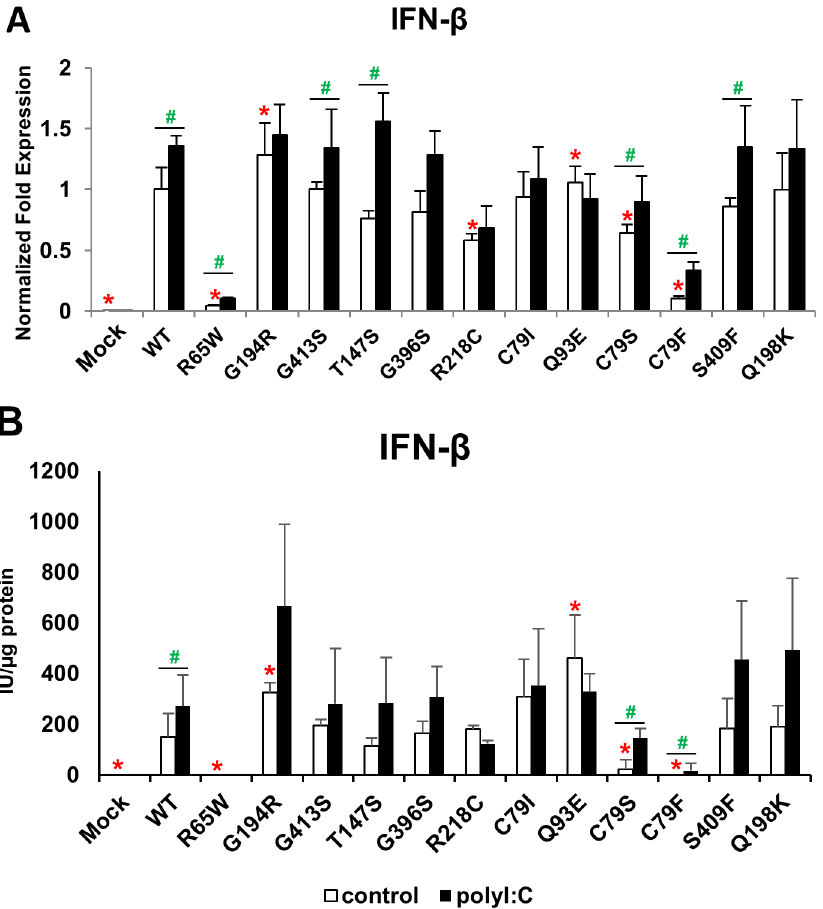
Fig 4. Effects of MAVS SNPs on antiviral signalling in response to poly I:C. Twenty-four hours after transfection with a mock, WT or variant MAVS expression plasmid, stably MAVS-silenced 293-flp cells were further transfected with poly I:C (500 ng/well) for 8 h. A. The mRNA levels of IFN- β were determined using quantitative RT-PCR. B. The levels of IFN- β protein in the culture medium were analysed by ELISA. The data are presented as the mean ± SD of three independent experiments. * P < 0.05 vs WT MAVS; #P < 0.05 vs poly I:C transfection.